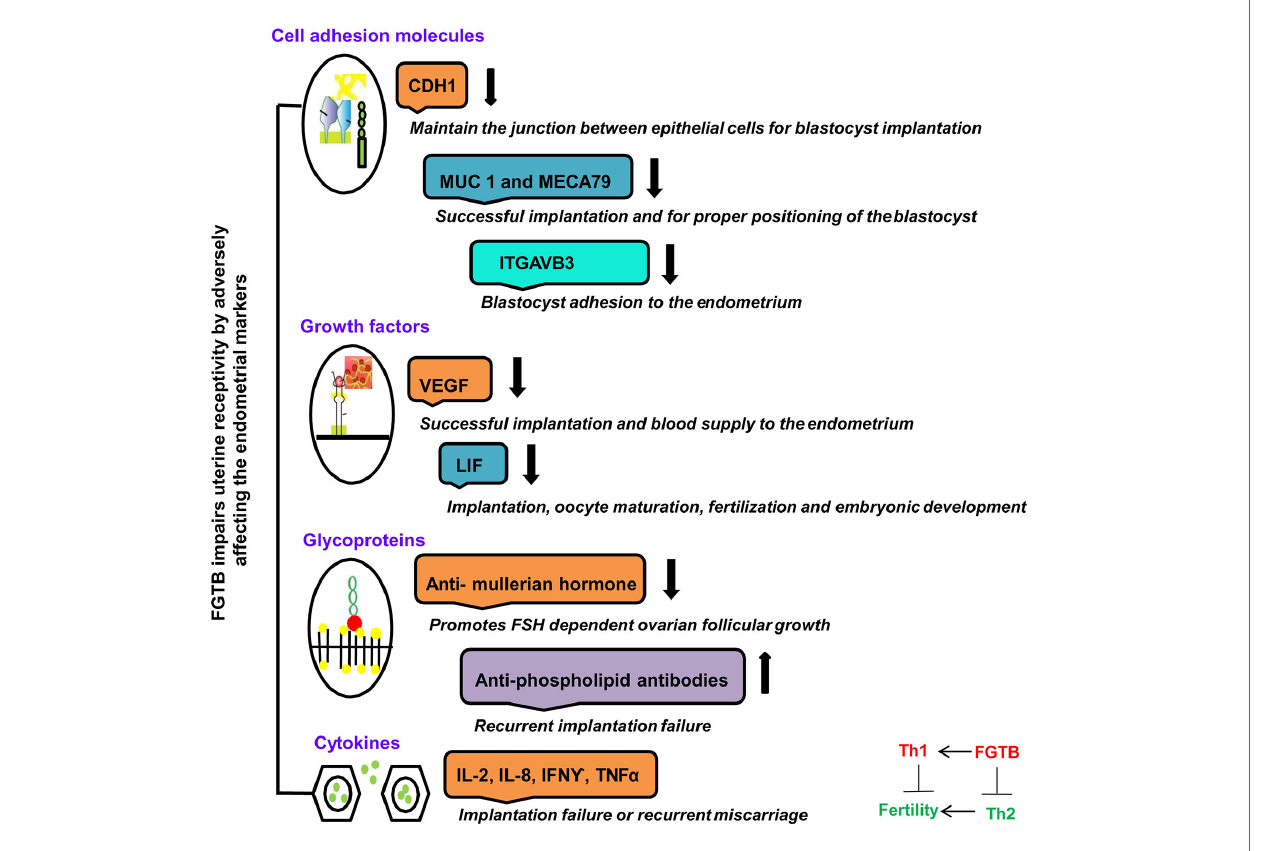
FIGURE 3 | FGTB: Immune dysregulation compromises female fertility. The impact of FGTB on female fertility is depicted. FGTB adversely affects uterine receptivity through immune dysregulation. Various cell adhesion molecules, growth factors, glycoproteins, and cytokines mentioned here are potential biomarkers of uterine receptivity and for successful placentation. FGTB lowers the level of CDH1, MUC1, MECA79, and ITGAVB3, leading to recurrent implantation failure. Similarly, FGTB pares down the levels of VEGF and LIF, which are required for successful placentation, thus creating an unfavorable environment for embryonic implantation. Glycoproteins and cytokines are also required for embryonic development. FGTB also affects embryonic development through upregulating proin fl ammatory cytokine expression and antiphospholipid antibodies as well as by lowering anti-in fl ammatory cytokine expression and ovarian reserve markers, such as the antimullerian